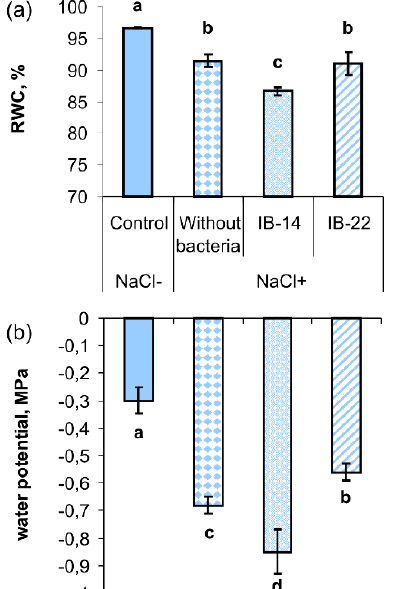
Figure 5. Effects of 100 mM NaCl and rhizospehere inoculation with P. mandelii IB -Кi14 (IB-14) and B. subtilis IB -22 (IB-22) on the relative water content ( a ), leaf water potential ( b ) of 13-days-old wheat plants. Control—option without bacterization and salinity. Significantly different means for each variable are labeled with different letters ( n = 8, p ≤ 0.05; LSD test).